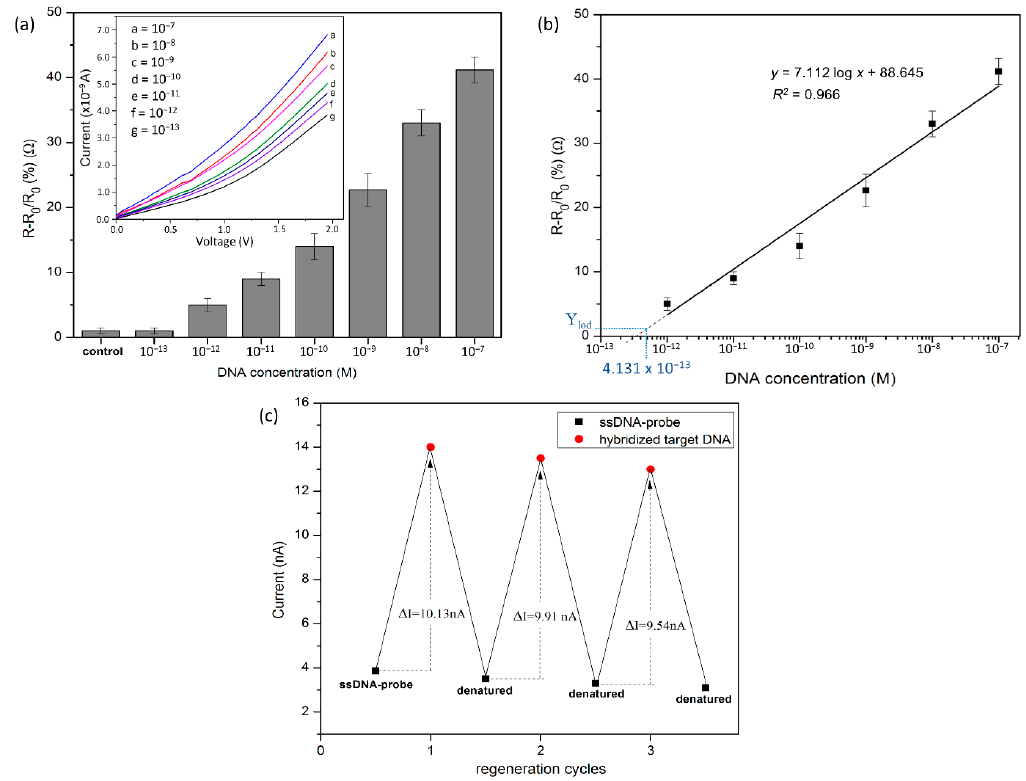
Figure 8. ( a ) The detection response of the fabricated SiNW device towards different concentrations of fully complementary target DNA. ( b ) The calibration curve of the resistance changes corresponding to the target DNA concentration range of 1.0 × 10 − 12 M to 1.0 × 10 − 7 M. ( c ) The regeneration of ssDNA-functionalized